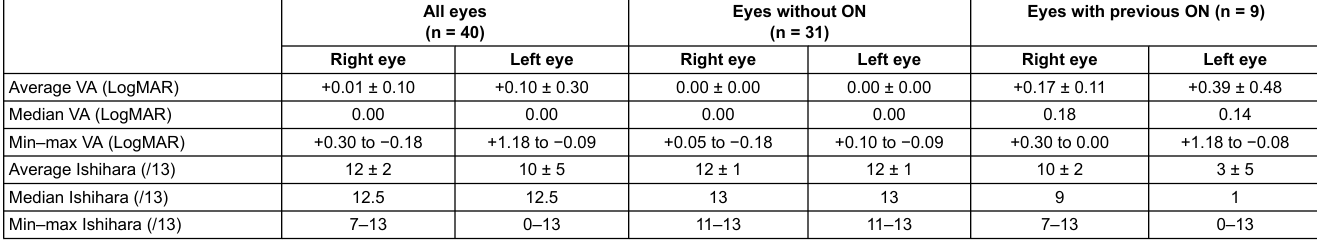
Table 2: Visual function of patients with multiple sclerosis and homonymous visual field